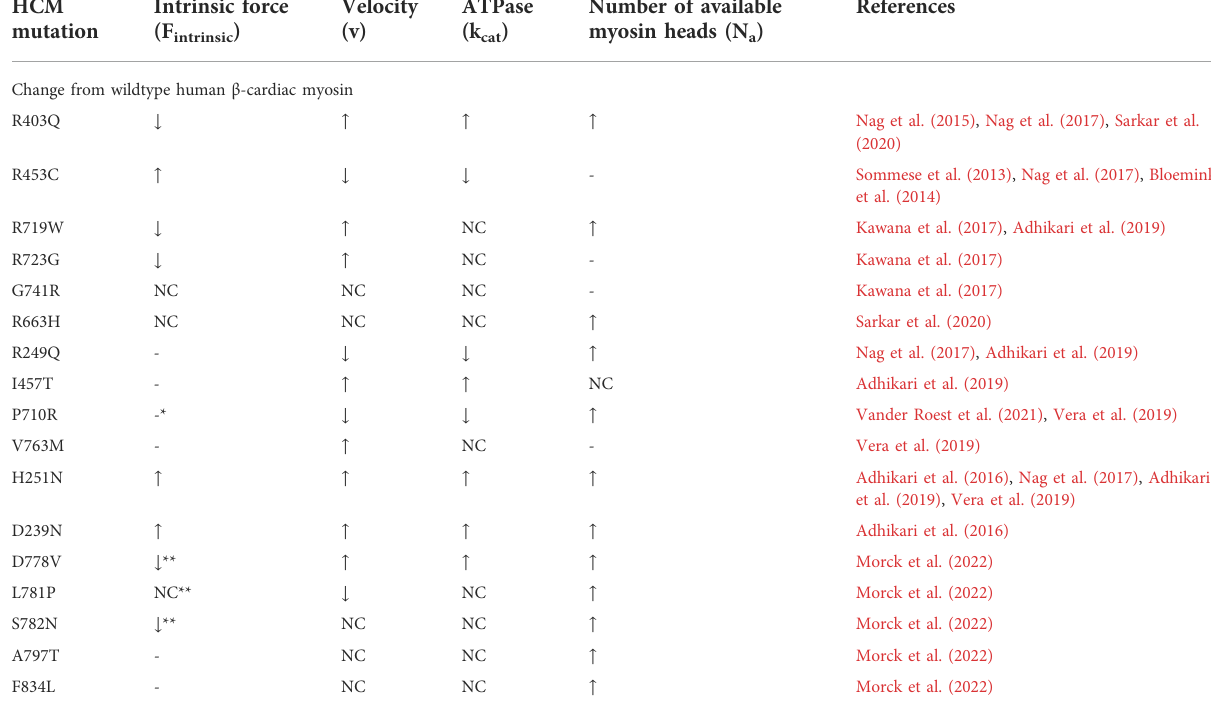
TABLE 1 Summary of the functional effect of HCM mutations in cardiac myosin. HCM